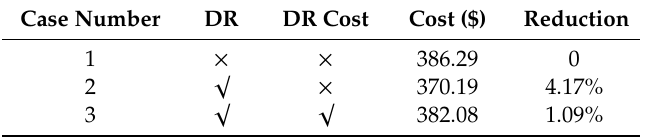
Table 3. Optimal operation strategy cost of a microgrid in three cases. DR: demand response.